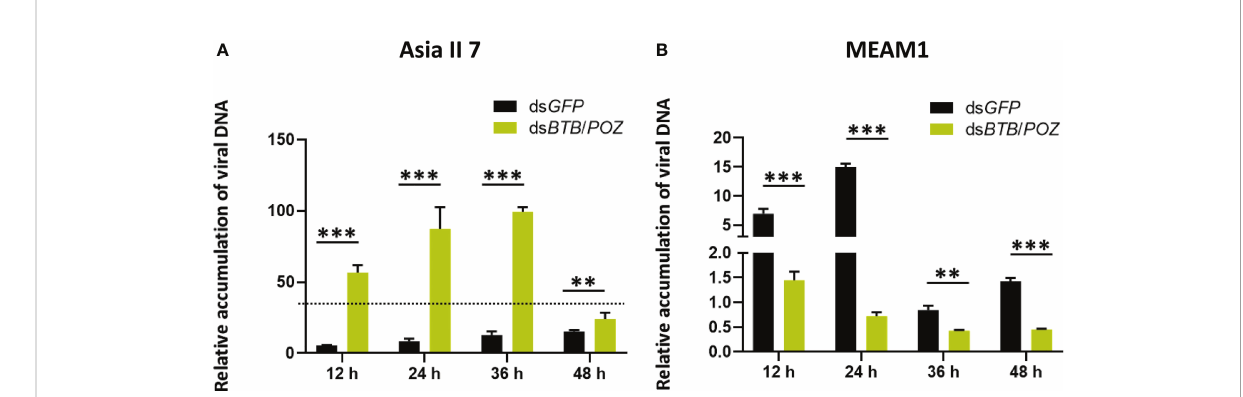
FIGURE 6 BTB/POZ silencing differentially affects virus acquisition/accumulation rates by white fl ies. Post-dsRNA treatment (A) Asia II 7 white fl ies were allowed to acquire virus and qPCR-based quanti fi cation of the viral DNA was performed at 12 h ( P =0.00001), 24 h ( P = 0.00001), 36 h ( P = 0.00834) and 48 h ( P = 0.000269). (B) Quanti fi cation of the viral DNA was also compared between ds GFP and ds BTB / POZ -fed MEAM1 white fl ies at 12 h ( P =0.00001), 24 h ( P = 0.00175), 36 h ( P = 0.00175) and 48 h ( P = 0.00001). Differences between treatments were analyzed by independent t -test and the statistical signi fi cance was de fi ned as: ** P < 0.01 and *** P <